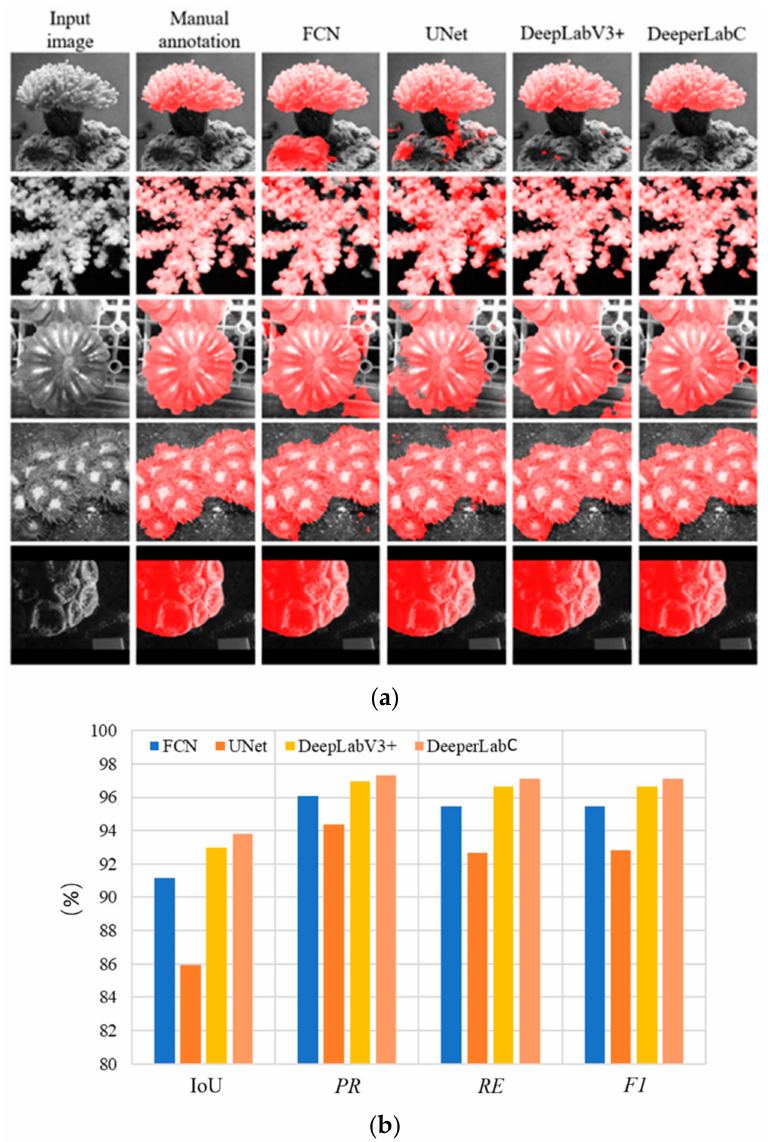
Figure 11. Comparison of semantic segmentation results of different CNN models: ( a ) Segmentation results visualization; ( b ) Statistical comparison of CNN models for semantic